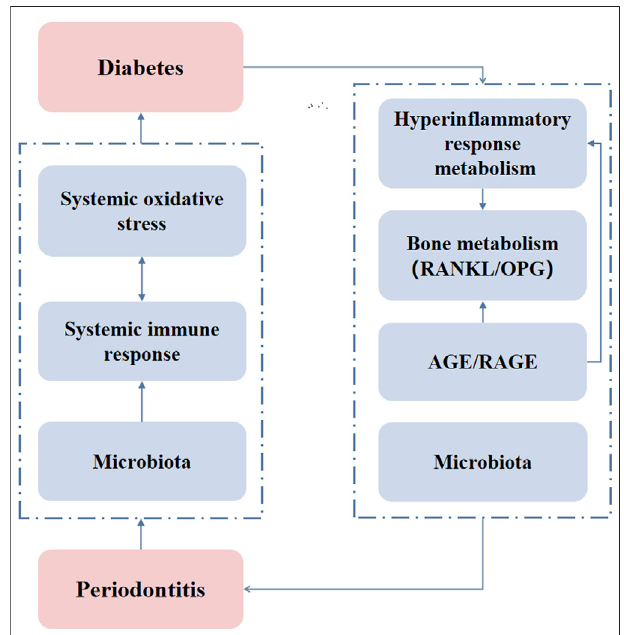
FIGURE2| Themechanismsofthetwo-wayrelationshipofperiodontitis and diabetes. AGE/RAGE: advanced glycation end product/receptor of advanced glycation end